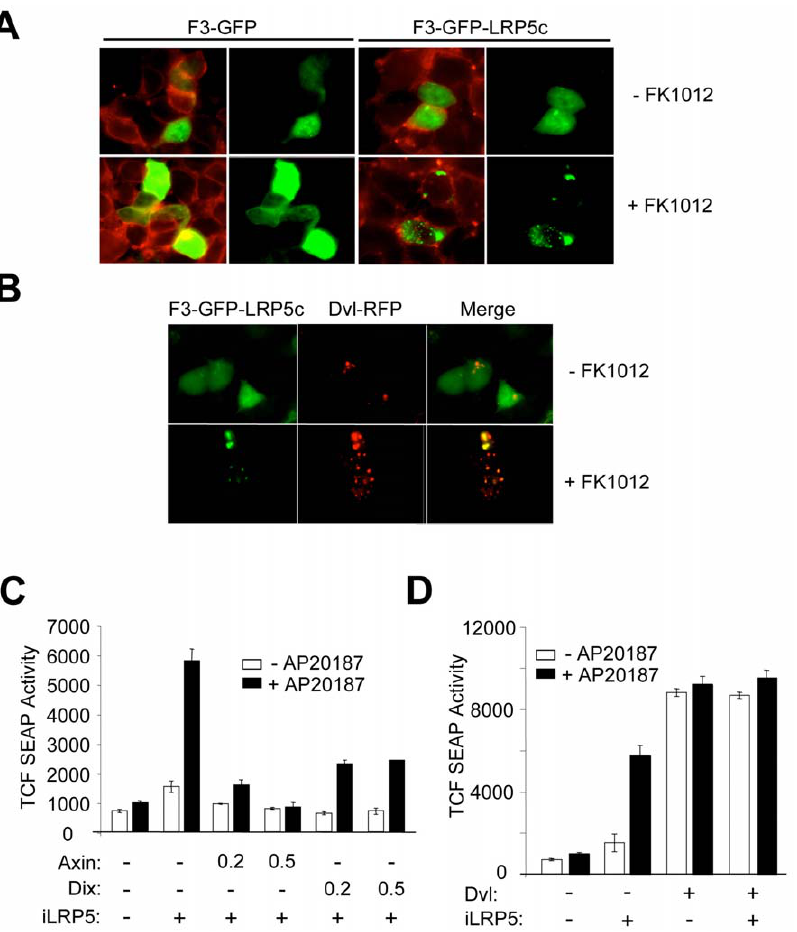
Figure 3. Dimerized-iLRP5 localizes to disheveled-containing punctate structures. ( A, B ) Subcellular localization of dimerized LRP5c and disheveled. 293 cells were transfected with 1 m g each of plasmids expressing drug-binding domains fused with GFP (F3-GFP) or GFP-LRP5c (F3-GFP- LRP5c) with (B) or without (A) RFP-fused disheveled construct, Dvl-RFP. Twenty-four hours after transfection, 100 nM FK1012 was added for an additional 24 hours to induce F3-LRP5c dimerization. After fixation, cells were labeled with cholera toxin B (CTx-B-TRITC) (A) and examined by fluorescence microscopy. ( C, D ) Independent role of iLRP5 and disheveled in b -catenin activation. 293 cells were transfected with 1 m g TCF-SEAP reporter along with 0.5 m g of iLRP5 and the indicated amounts ( m g) of Axin or dominant negative disheveled (Dix) constructs (C) or 0.5 m g disheveled construct (D). Twenty-four hours after transfection, 100 nM CID was added and SEAP activity was measured after 24 hours. Data is representative of at least three independent experiments (A, B). Error bars indicate mean 6 S.D. of triplicate measurements (C. D).